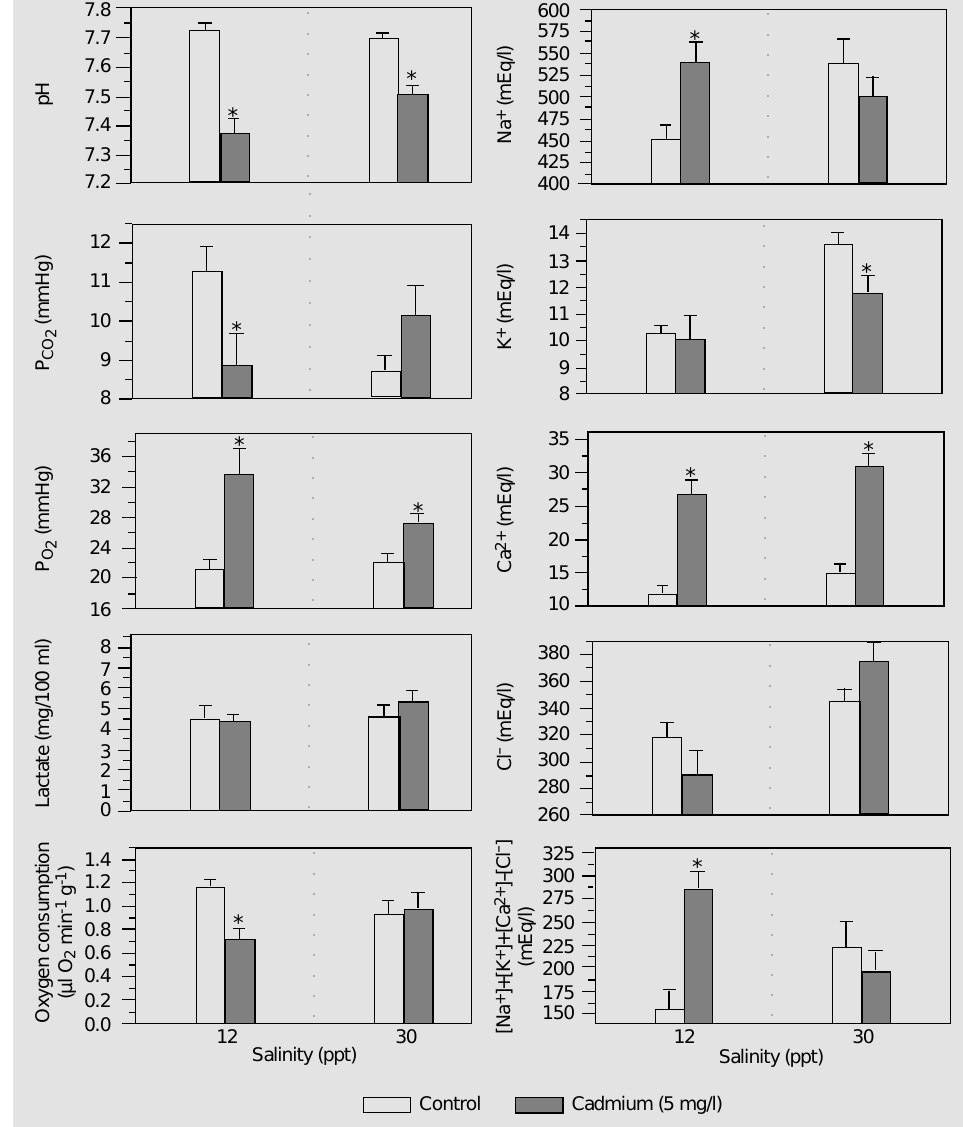
mg/l)Figure 3 - Mean values (± SEM) of hemolymph parameters and physiological variables for Chas- magnathus granulata exposed to cadmium for 2 weeks at 12 and 30‰ (ppt) salinity. Control: Wa- ter dilution control. N = 10, ex- cept for 5 mg/l cadmium at 12‰ salinity (N = 6). *P<0.05 com- pared to control (two-way ANOVA followed by planned comparisons